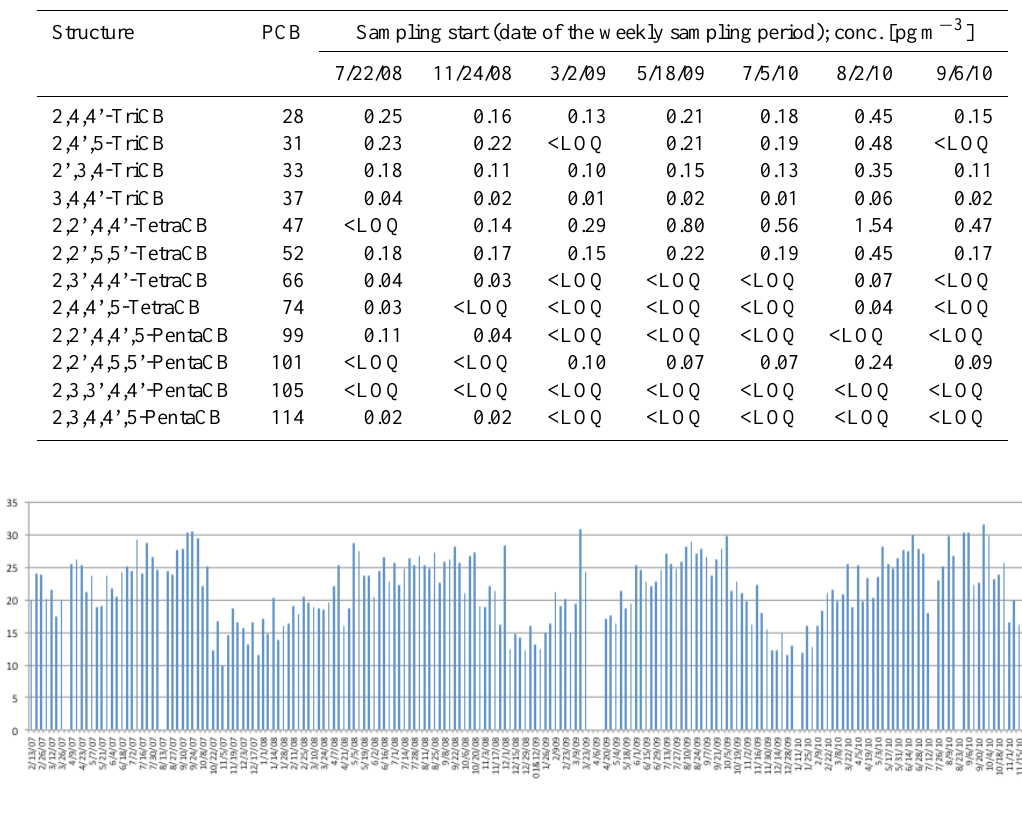
Fig. 2. Concentration distribution of hexachlorobenzene (HCB) in atmospheric samples from Troll (Antarctica); period: 2007–2010; x-axis: sampling start date; y-axis: conc. [pgm − 3 Figure 2: Concentration distribution of hexachlorobenzene (HCB) in atmospheric samples 4 from Troll (Antarctica), period: 2007 – 2010, x-axis: sampling start date; y-axis: 5 conc. [pg/m 3 ] 6